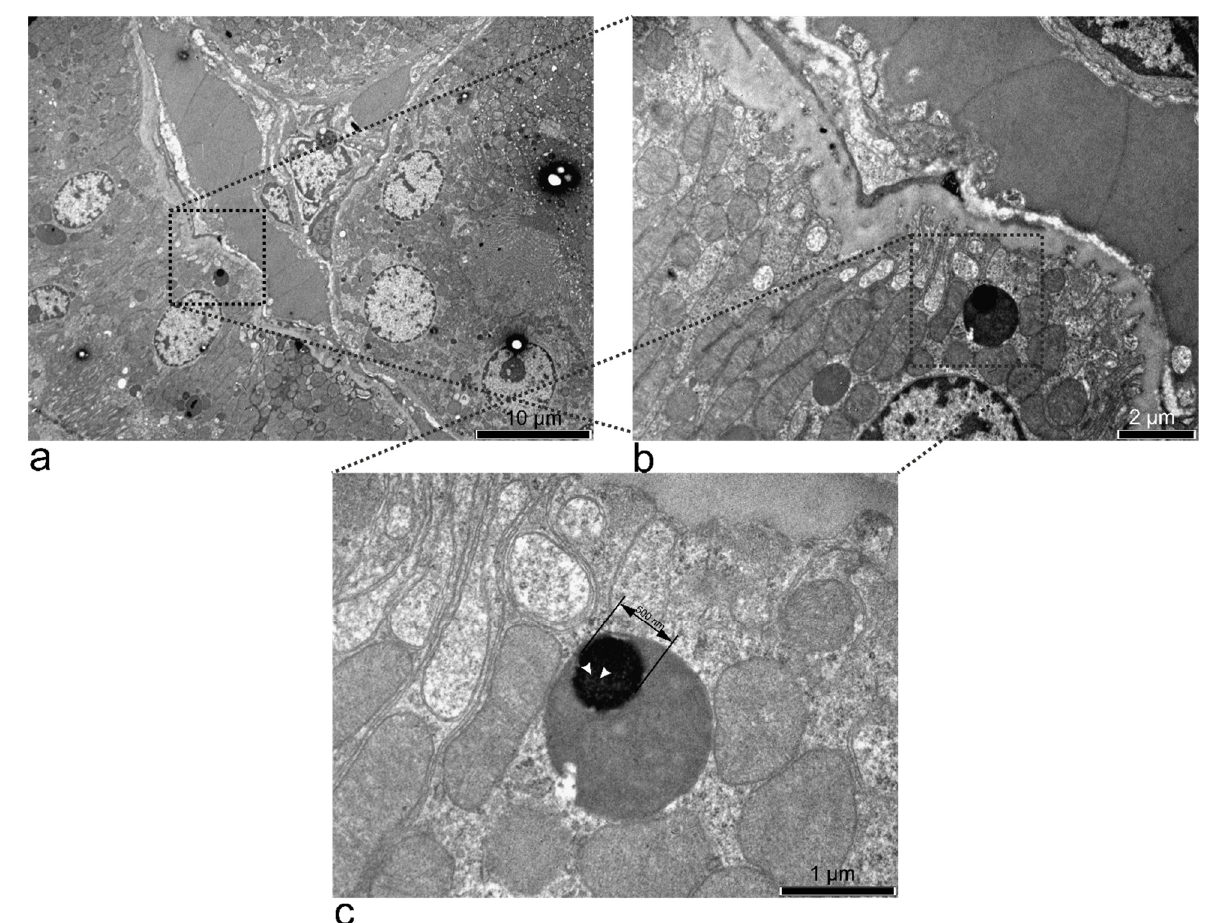
Figure 8. TEM micrographs of the kidney treated with SPION-PEG clusters for 15 min ( a ). At a higher magnification, a dark lysosome was observed ( b ). The lysosome had a large electron-dense formation inside, with visible smaller particles (white arrows) that could be the 10 nm SPIONs ( c ).